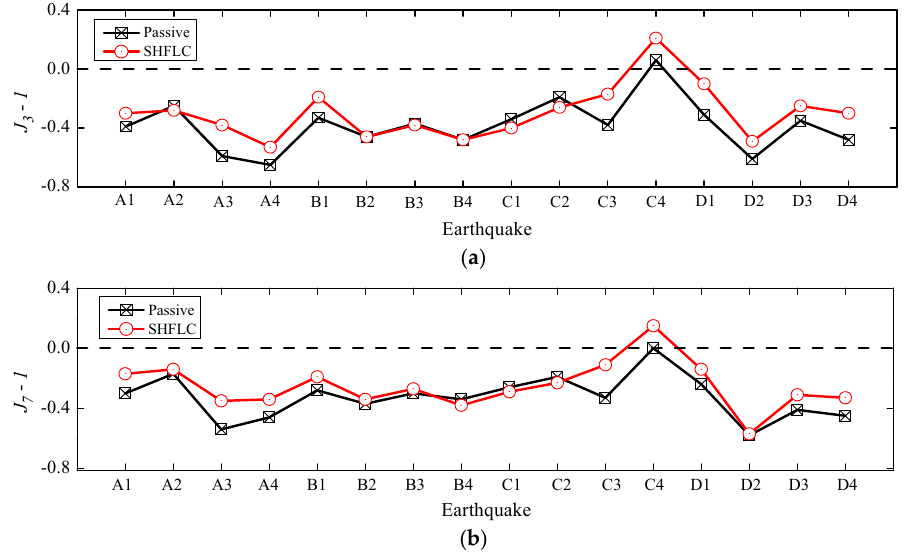
Figure 10. Performance indices J 3 and J 7 for different control cases under various types of earthquakes: ( a ) Performance index J 3 ; and ( b ) Performance index J 7 .